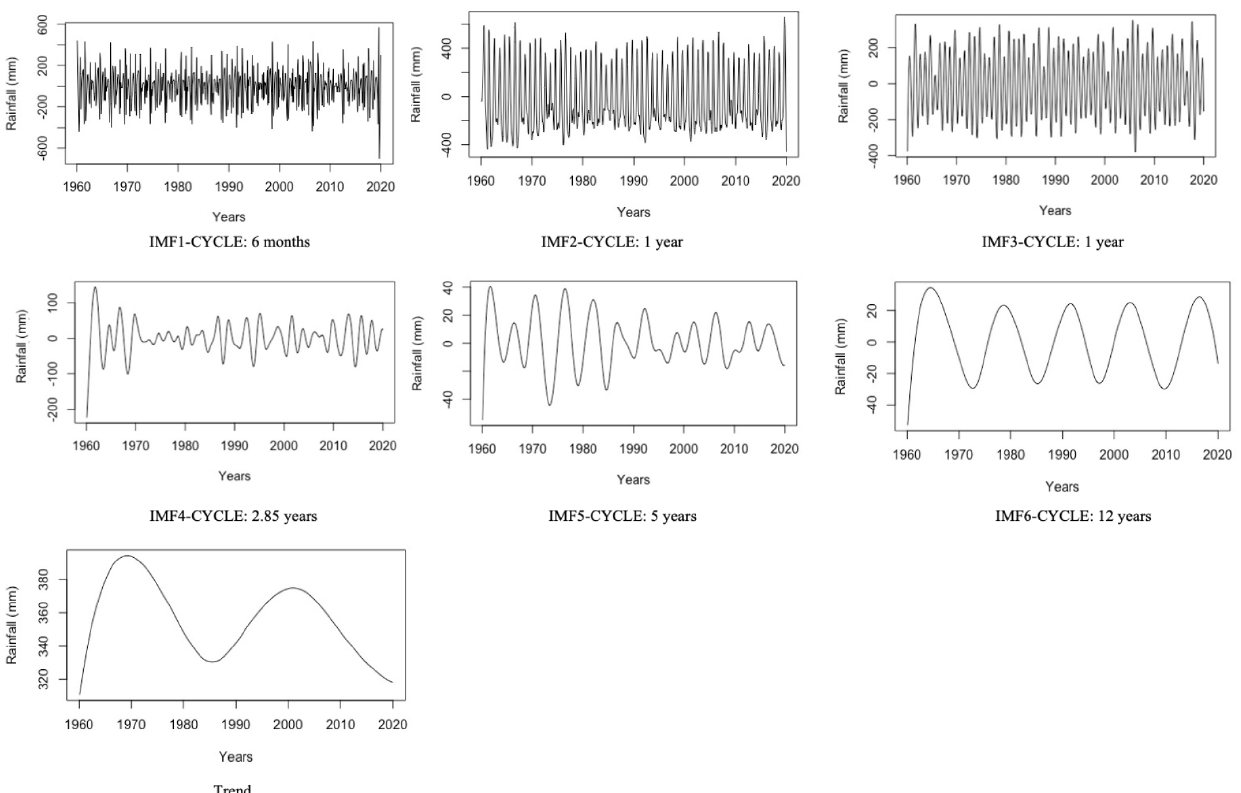
Figure 13. Relevant IMFs and trend from the EEMD applied to the Conakry rainfall time series from 1960 to 2019.